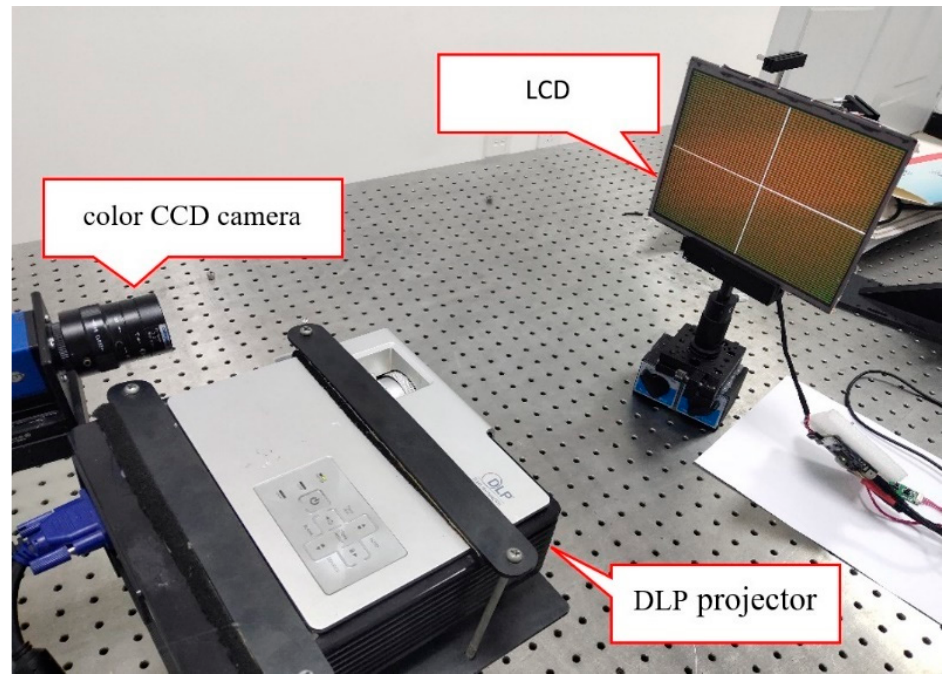
Figure 8. Hardware system diagram of the radial chromatic aberration experiment.